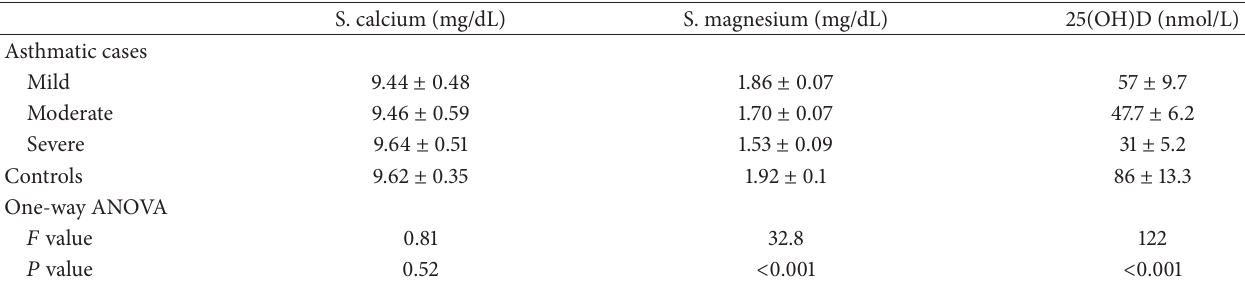
Table 6: Comparison of serum level of 25(OH)D, magnesium, and calcium in different grades of